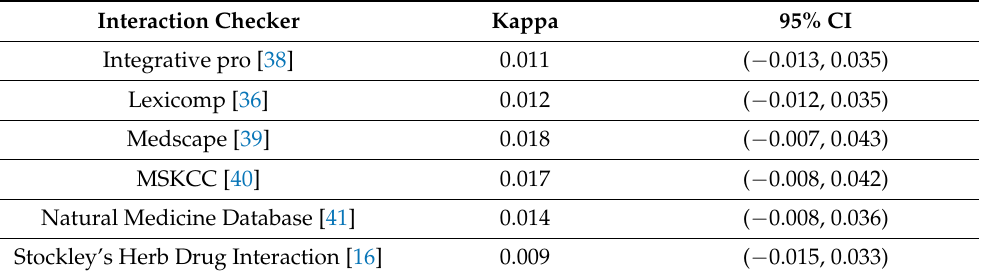
Table 4. Cohen’s kappa and 95% confidence intervals (CI) comparing checkers to case